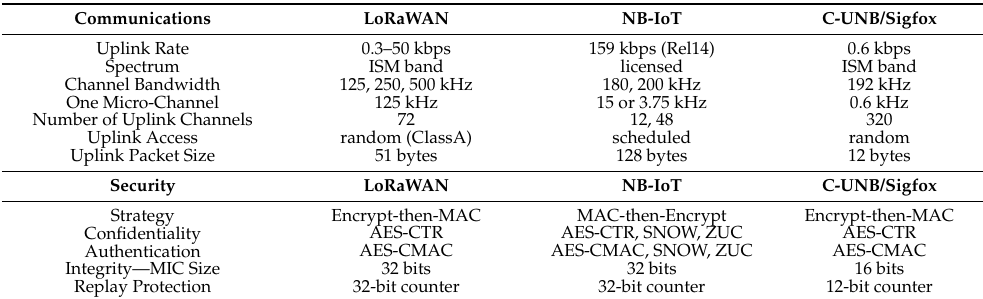
Table 6. Summary of LPWA networks’ communication and security